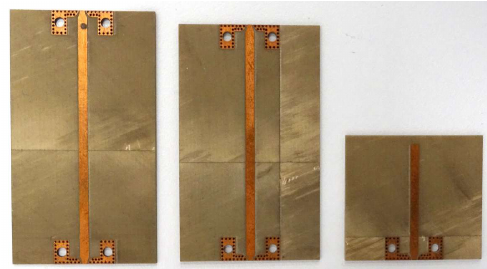
Figure 6. Custom TRL calibration kit.